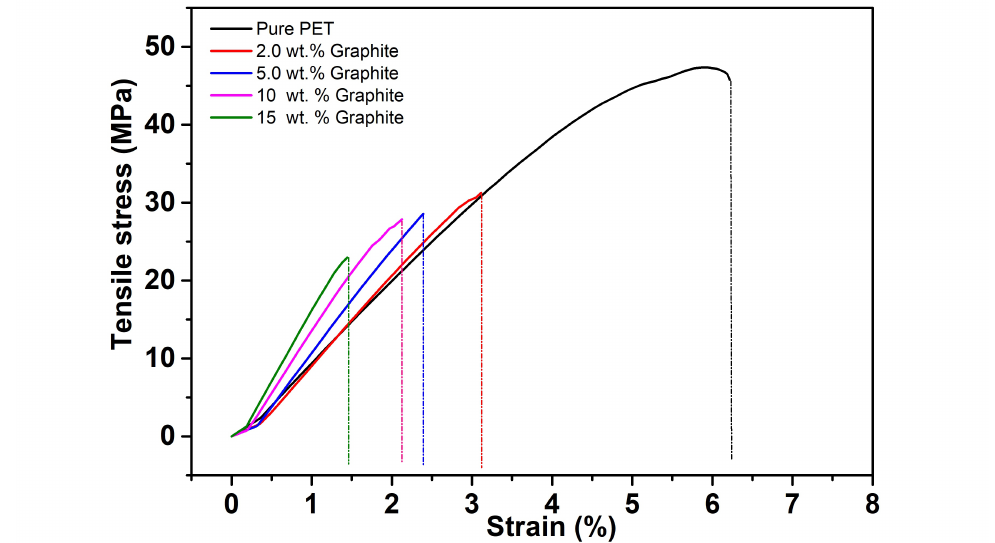
Figure 7. Stress–strain responses with respect to various graphite concentrations. As expected, the rigid graphite filler stiffens the PET matrix and reduces its